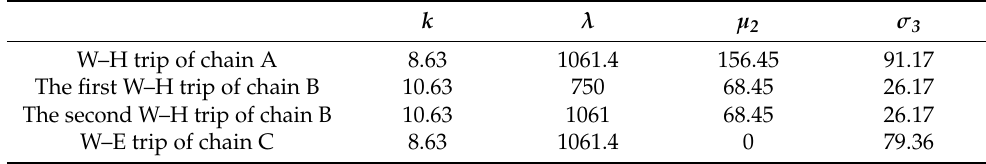
Table A2. Parameters for the distribution functions of µ and σ under different type 2 trips.